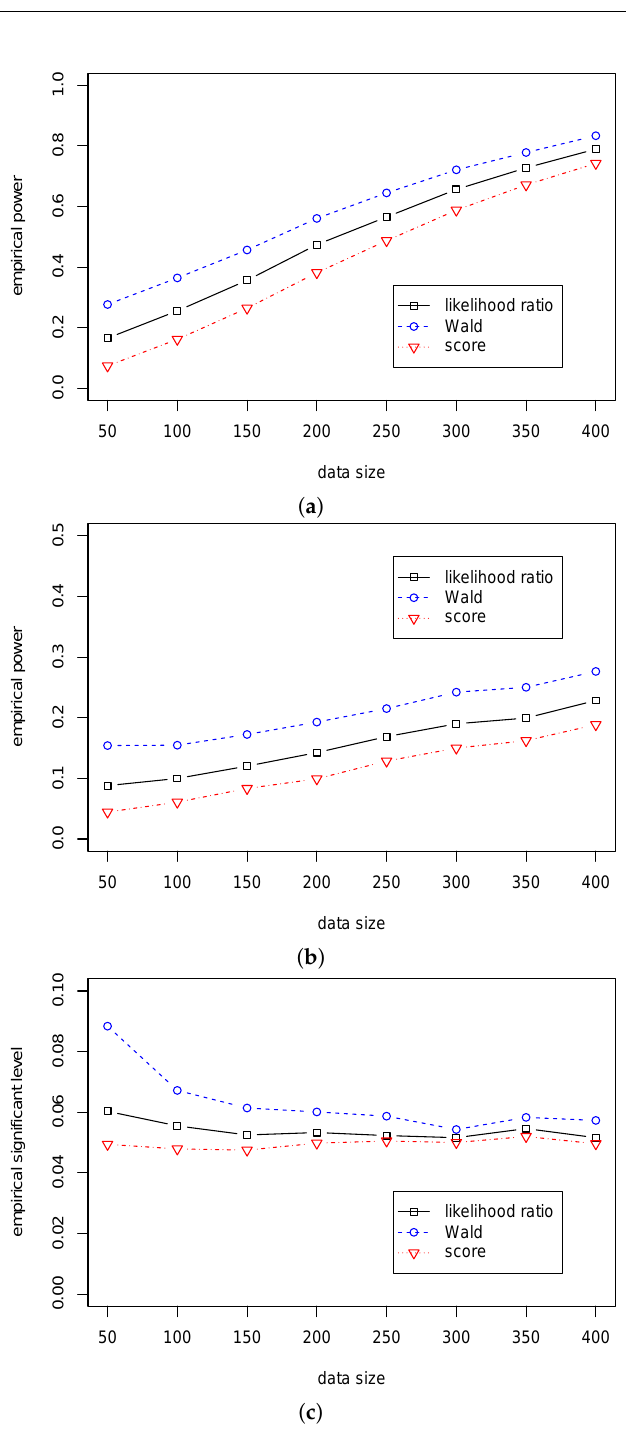
Figure 5. The empirical powers/level of three test statistics ( T L , T W , T S ) for testing H 0 : β 1 = 0 in Case (A3) for different α . ( a ) The empirical power with H 1 : β = ( 1,1 ) (cid:62) for α = 0.9; ( b ) The empirical power with H 1 : β = ( 1,1 ) (cid:62) for α = 0.95; ( c ) The empirical significant level with H 1 : β = ( 1,1 ) (cid:62) for α =